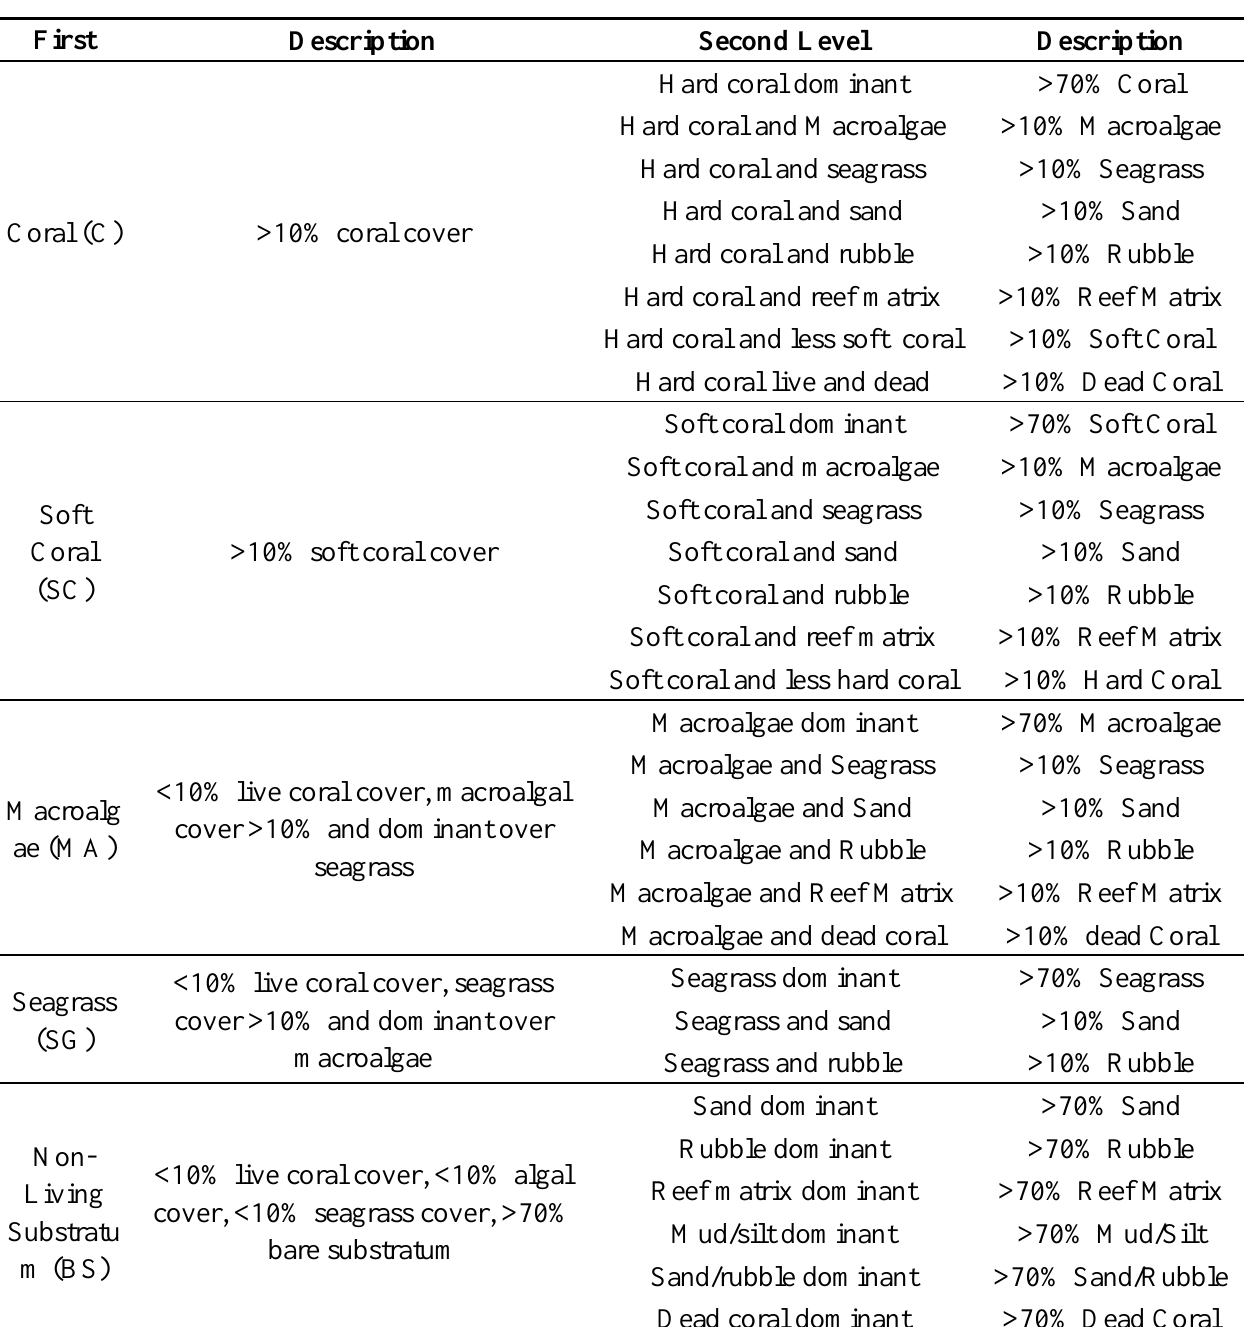
Table 1. Hierarchical scheme used for benthic classification of the photo transect